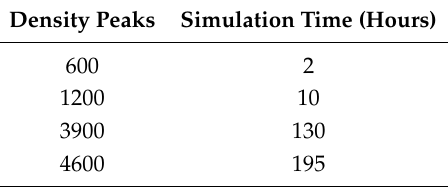
Table 7. Average simulation time.